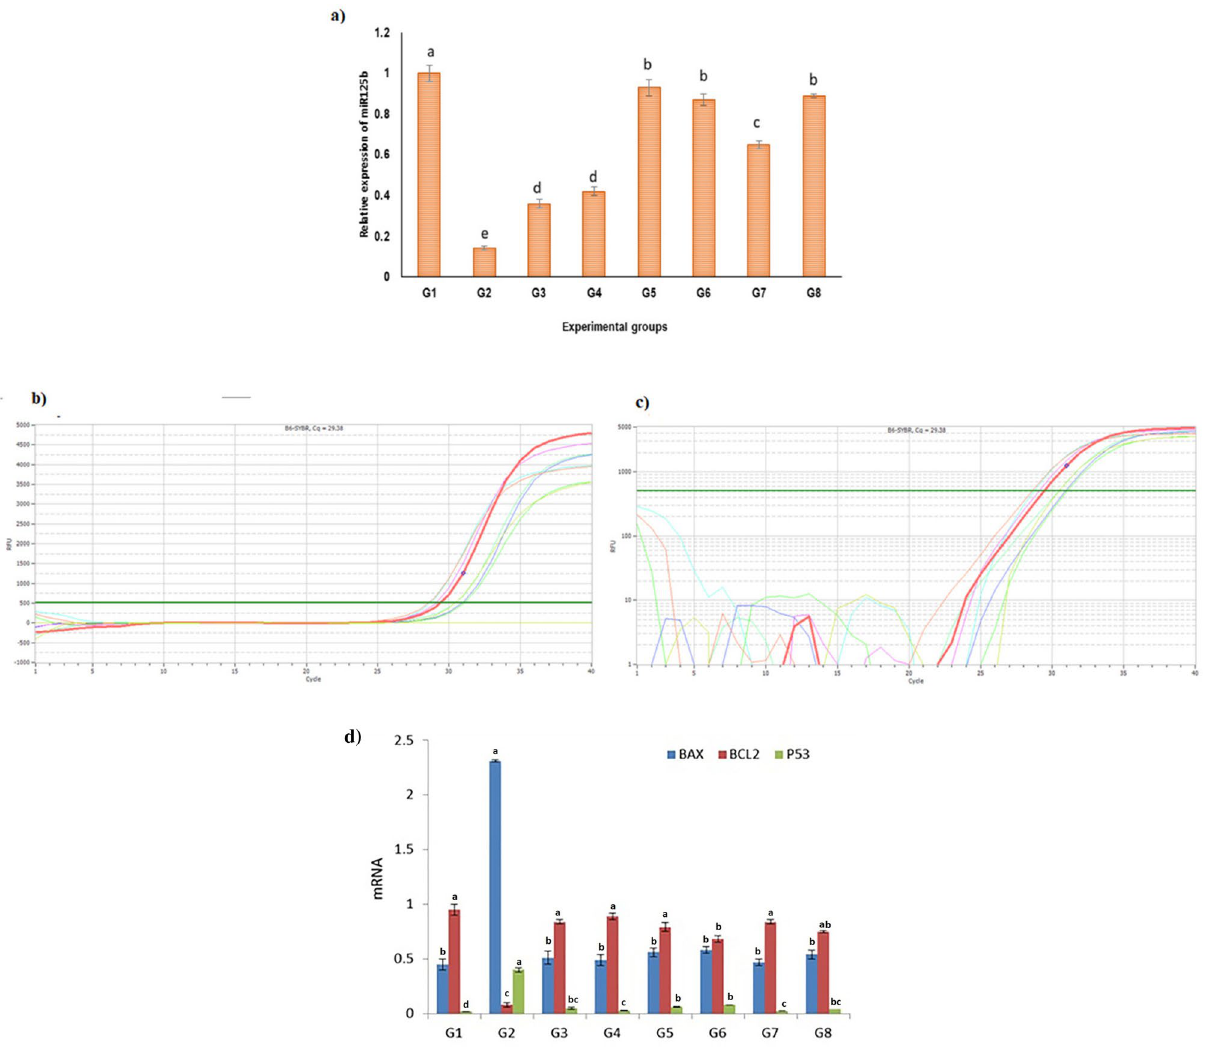
Figure 4. (a) miR125b expression by real time PCR in serum of irradiated rats and after propolis and bee venom; (b,c) amplification curves for miR125b expression by real time PCR. (d) Effect of propolis and/ or bee venom on BAX, BCL2 and P53 in the irradiated rats. Data are expressed as mean ± SE. Means having different superscript letters within the same column are significantly different at p <